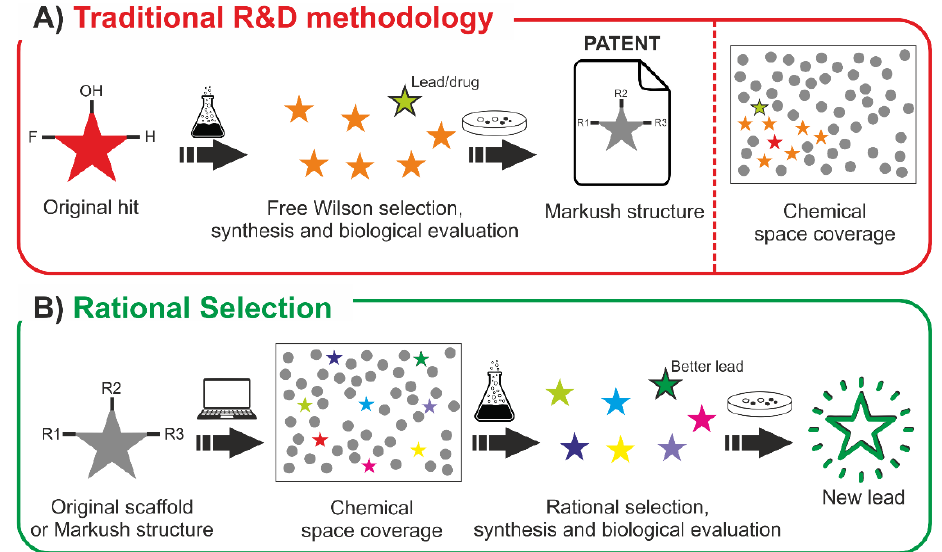
Figure 3. Hit-to-lead process comparative workflow between the traditional methodology ( A ) and the approach suggested by the authors after the reported study ( B ).